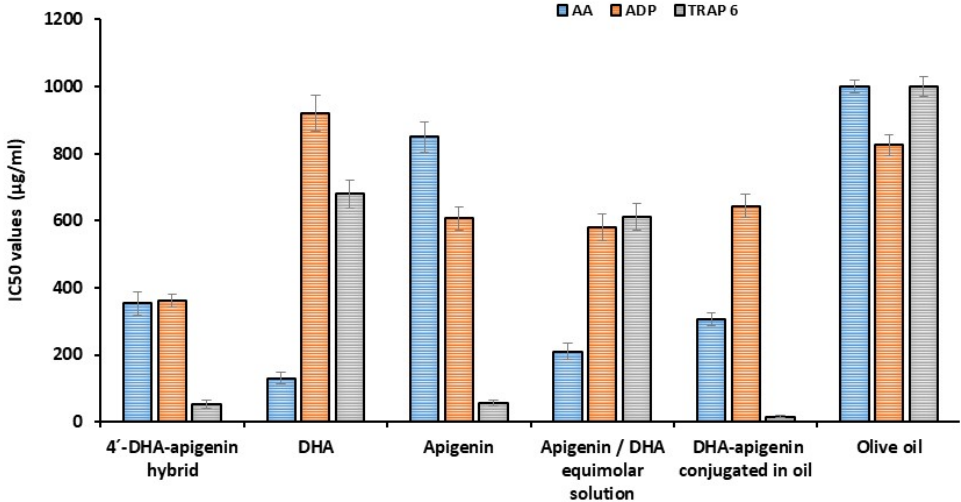
Figure 6. IC50 values of the inhibitory effect of 4 ′ -DHA-apigenin hybrid, DHA, apigenin, apigenin/DHA equimolar solution, 4 ′ -DHA-apigenin hybrid olive oil formulation, and olive oil on platelet aggregation induced by ADP, AA, or TRAP-6 in PRP. Bars represent the mean ± SD.